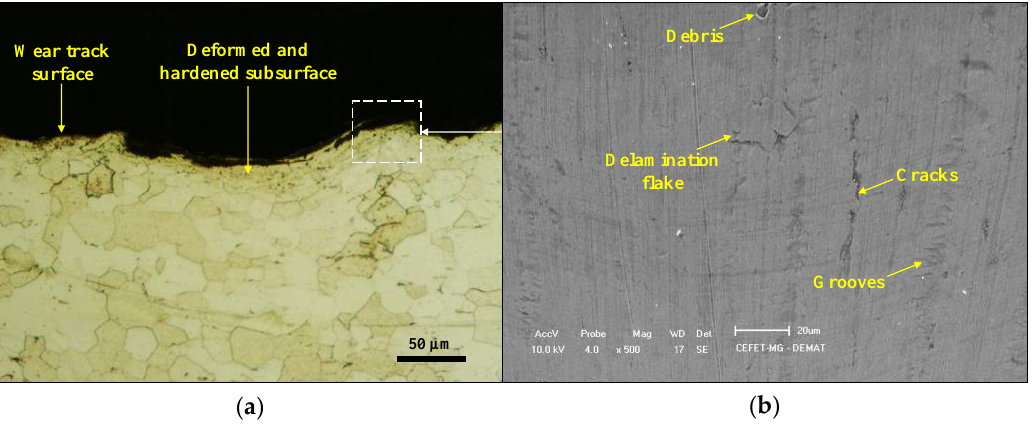
Figure 7. ( a ) Specimen section and ( b ) SEM image of the wear track surface.